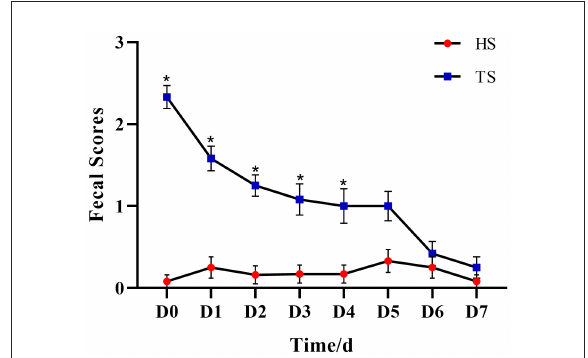
FIGURE1 The effect of Pueraria lobata polysaccharide (PLP) on fecal scores of calves. * P < 0.05 HS vs. TS, D0 means diarrheal calf without PLP treated (DS). HS, healthy calf fecal sample; TS, PLP treatment diarrheal calf fecal